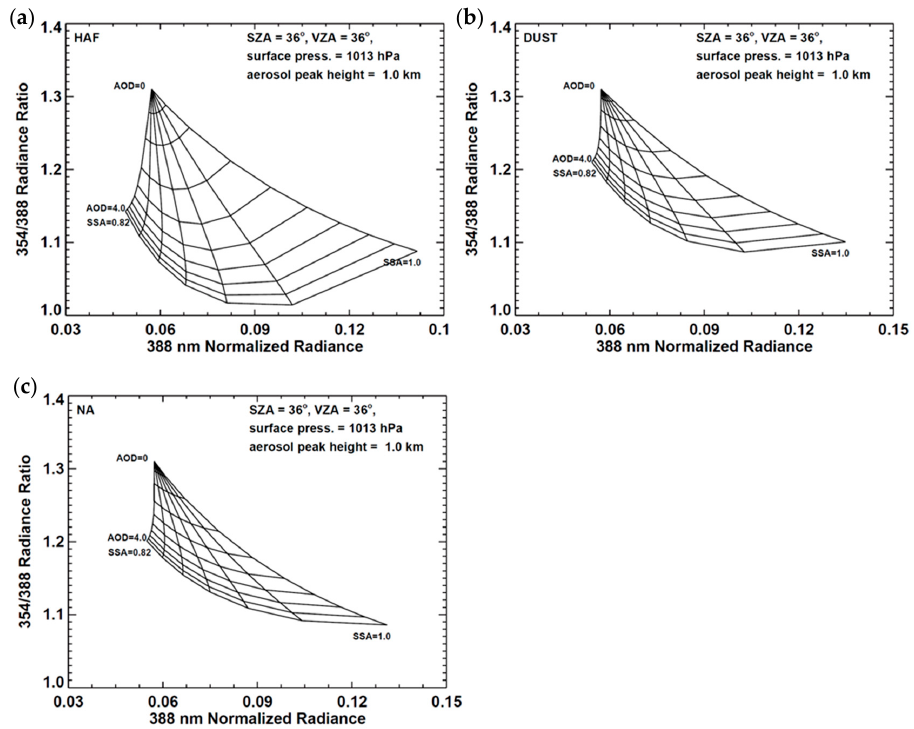
Figure 6. Example of LUT used to estimate a priori AOD and SSA for three different aerosol types: ( a ) HAF, ( b ) Dust and ( c ) NA. The x -axis represents the normalized radiance at 388 nm and the y -axis represents the ratio between the radiances at 354 nm and 388 nm.